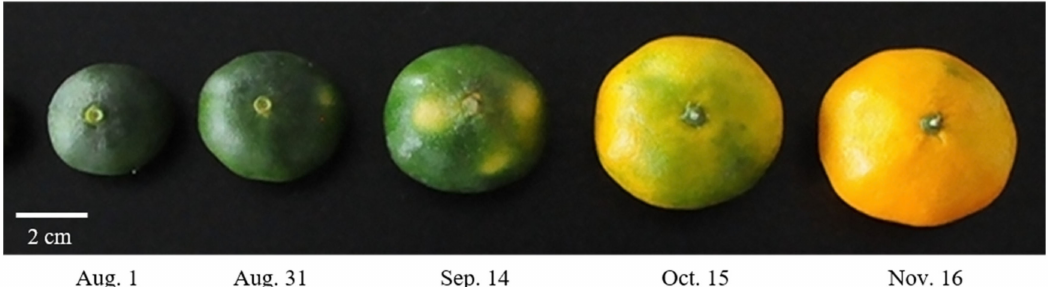
Figure 1. Appearance of Citrus unshiu fruit during fruit development.